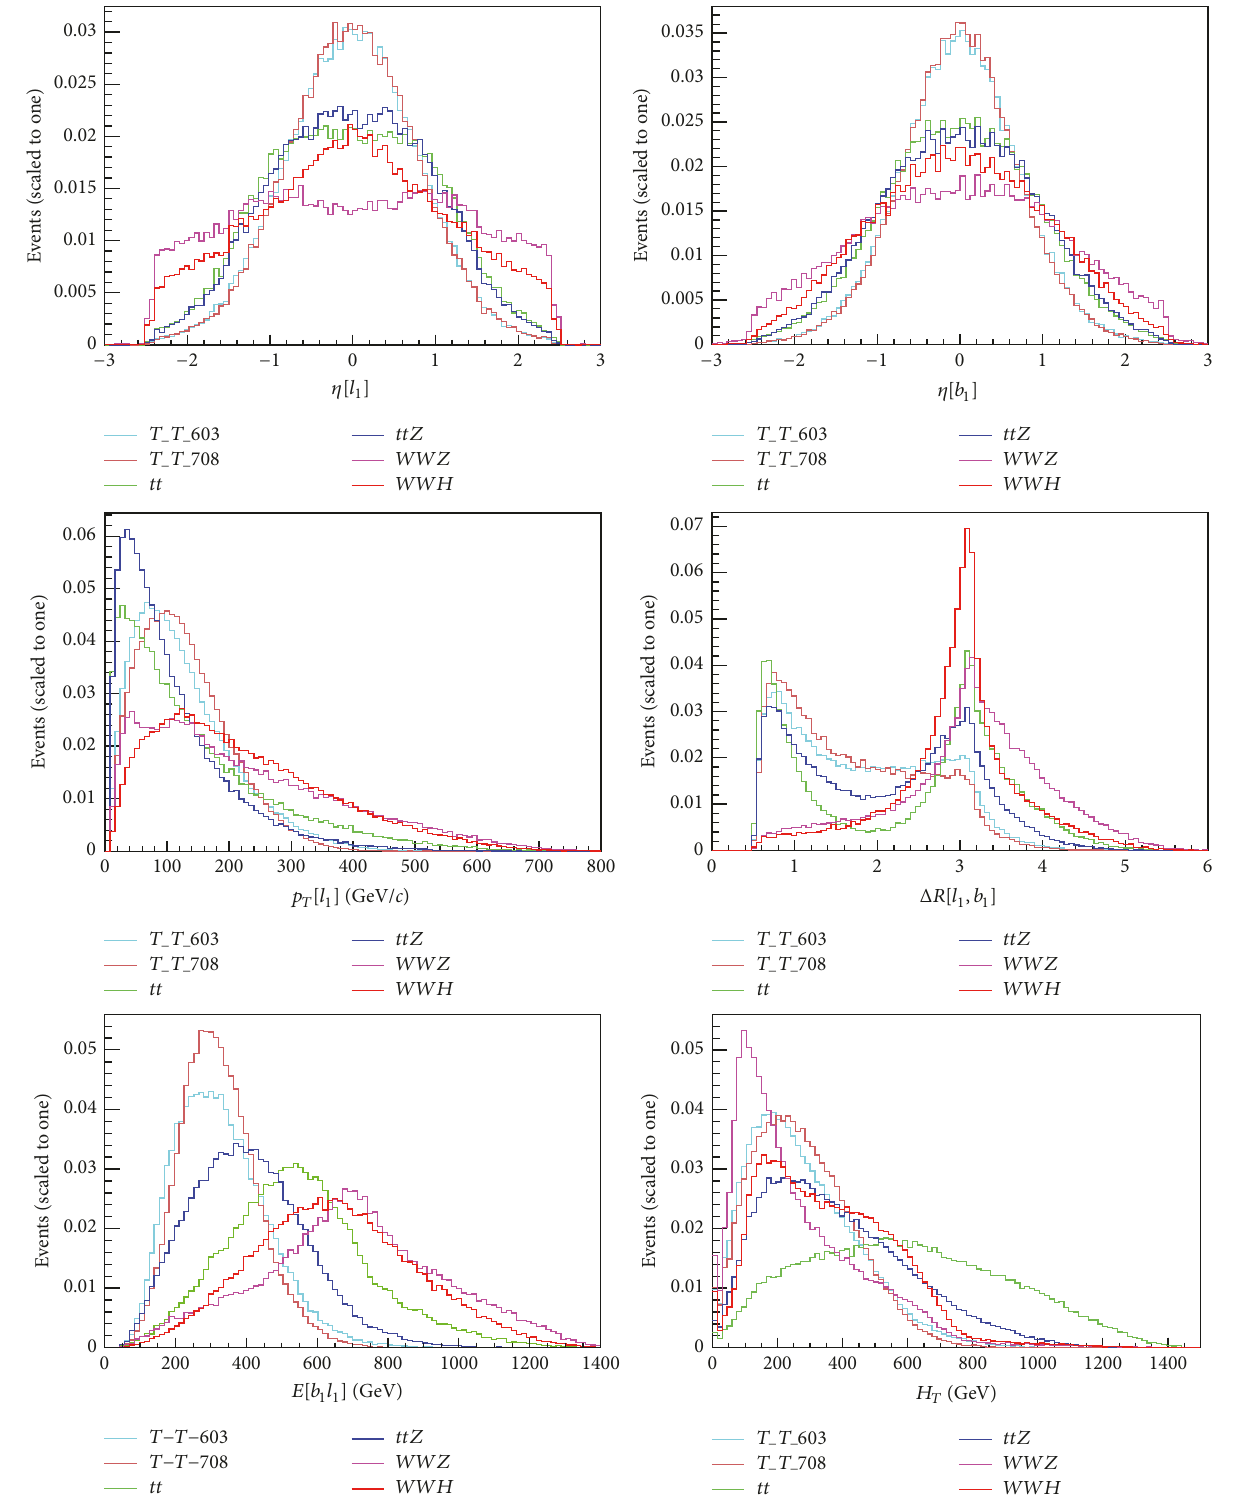
Figure 5: Normalized distributions of 𝜂 푙 at √ 𝑠 = 1.5